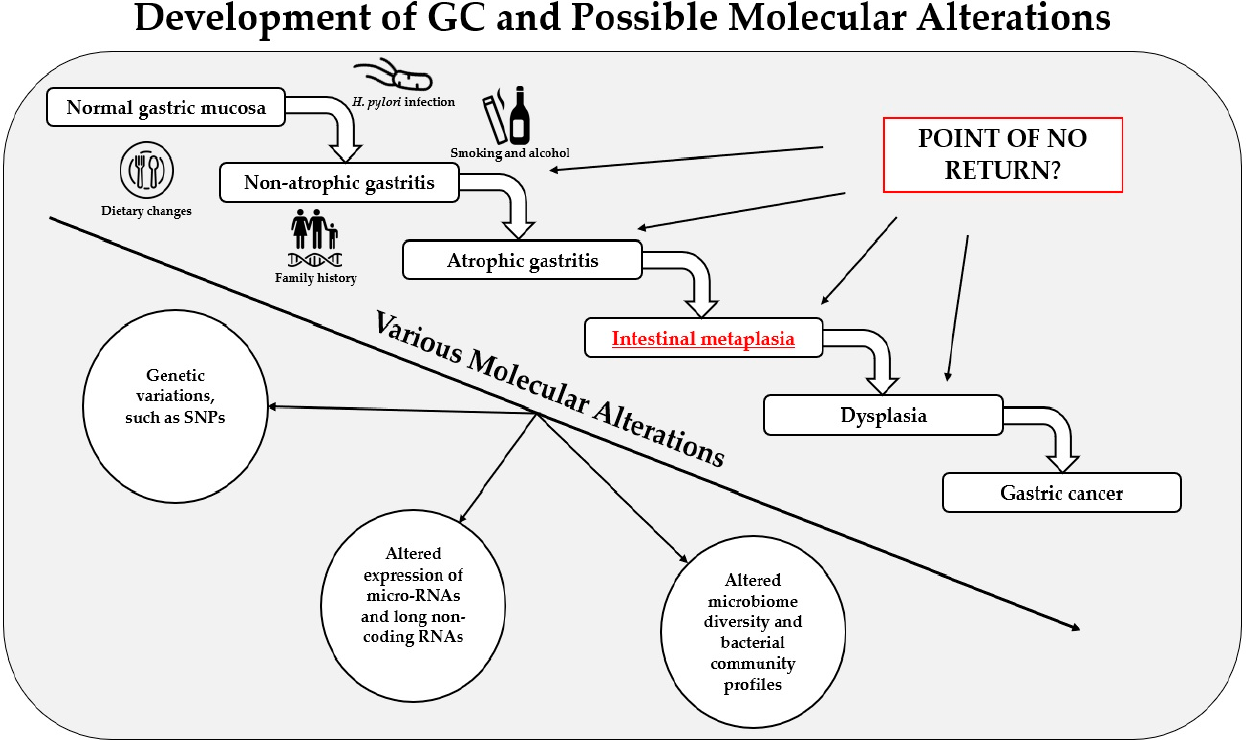
Figure 1. Development of gastric cancer (GC), the main causes and risk factors for it, and possible molecular alterations.